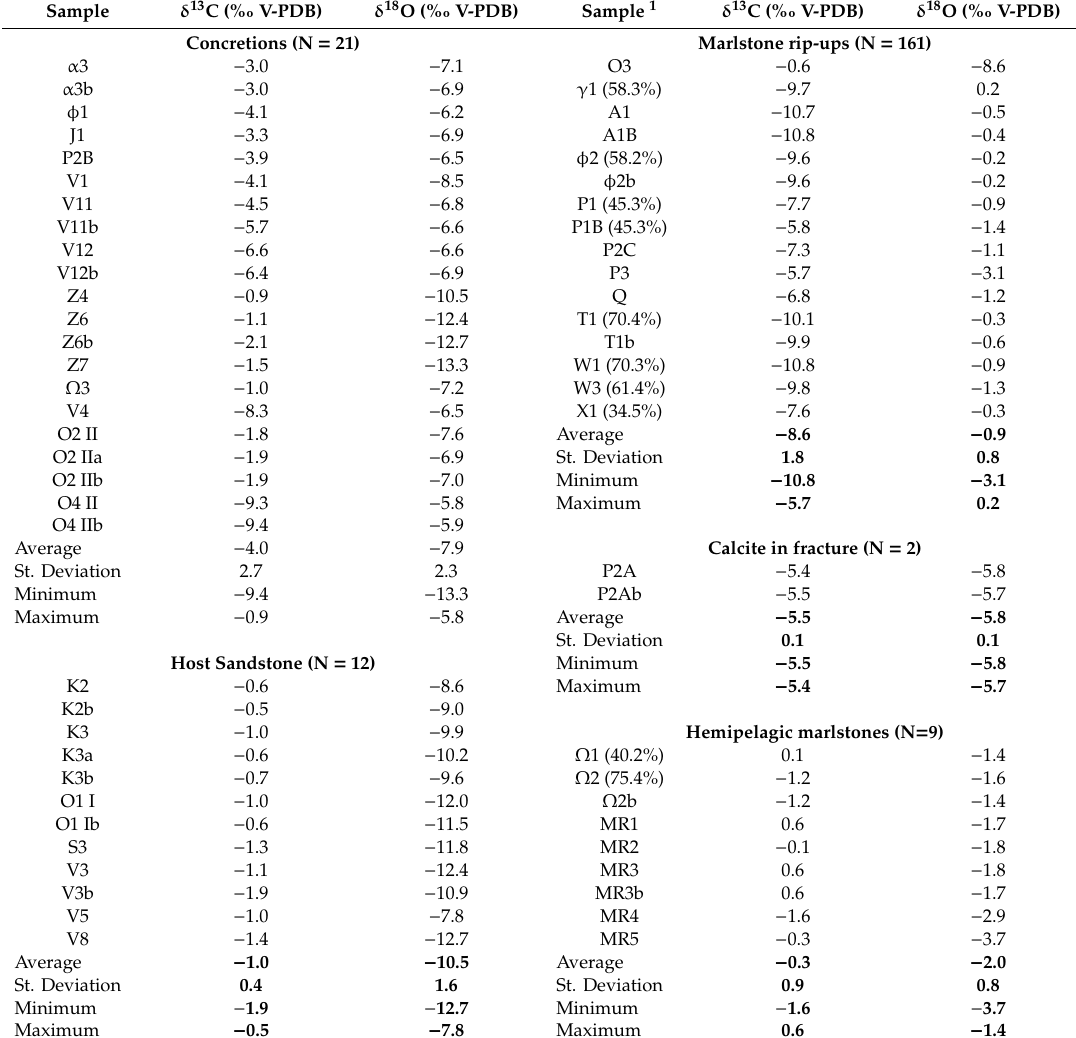
Table 3. Results of stable carbon and oxygen isotope measurements made on powders extracted from the concretions, the host sandstones and the marlstones rip-ups of CdV, and the hemipelagic marlstones below and above